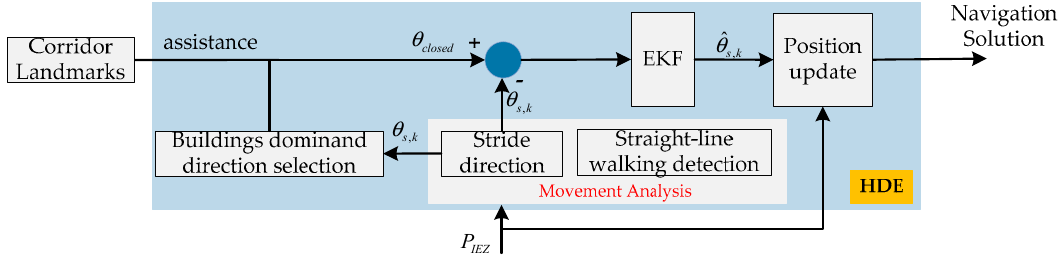
Figure 2 . The mechanism of heuristic drift elimination (HDE) algorithm with the assistance of manmade landmarks.